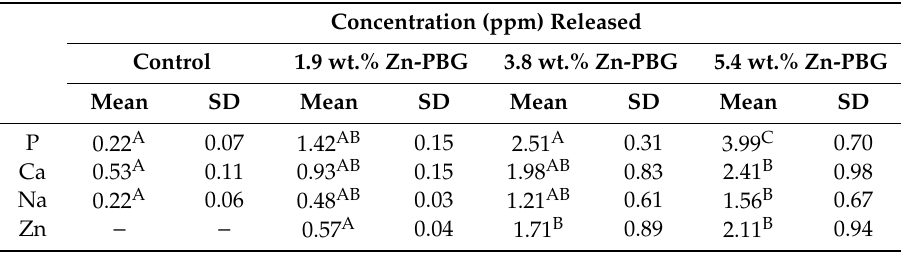
Figure 4. Concentrations of the major ions (Ca, P, and Zn) released from samples.